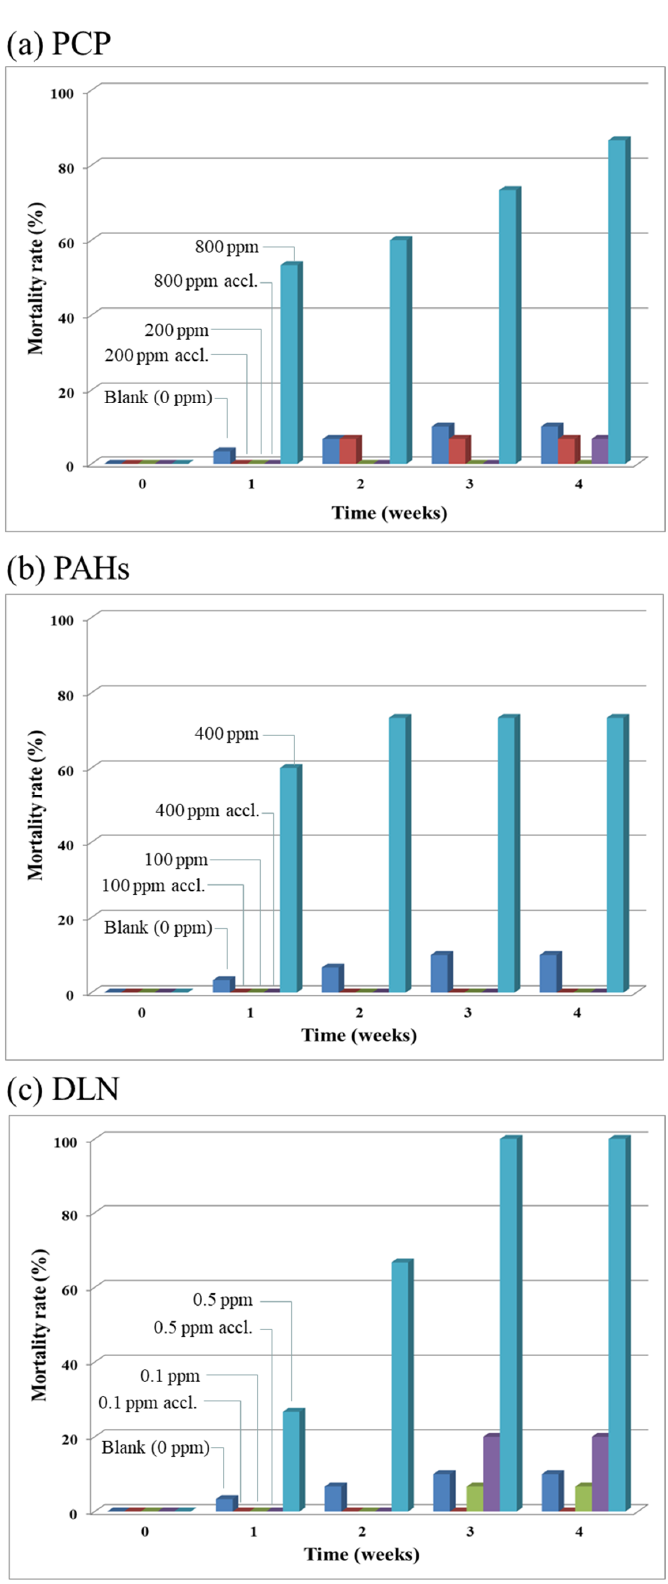
Figure 6. Larval mortality rates with or without acclimation to the tested PCP, PAHs and DLN, as labeled in ( a – c ), respectively.